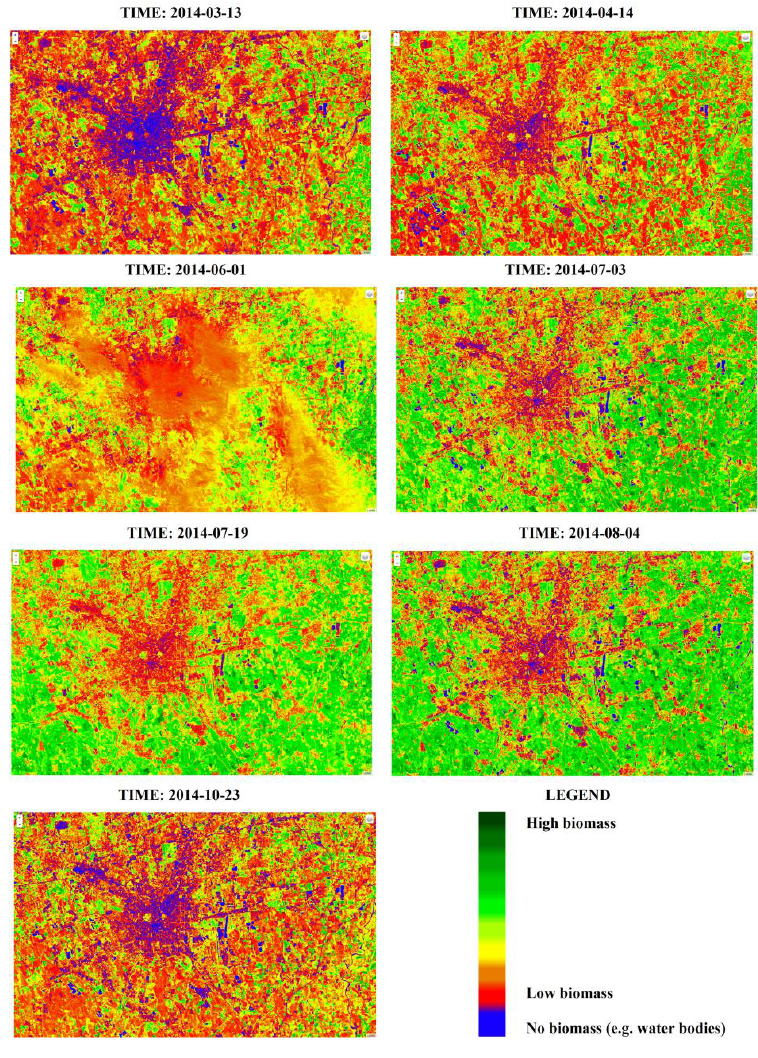
Figure 6. EVI 2014 time series layer: An example of a time series raster data published automatically on GeoServer Web GIS server deployed in S4A-SDI for the year 2014; the EVI vegetation index shown by each image is assumed to be a proxy of vegetation biomass. From left top to right down, individual datasets produced for a certain time period of the year 2014 and which define the final 2014 series layer (source: own